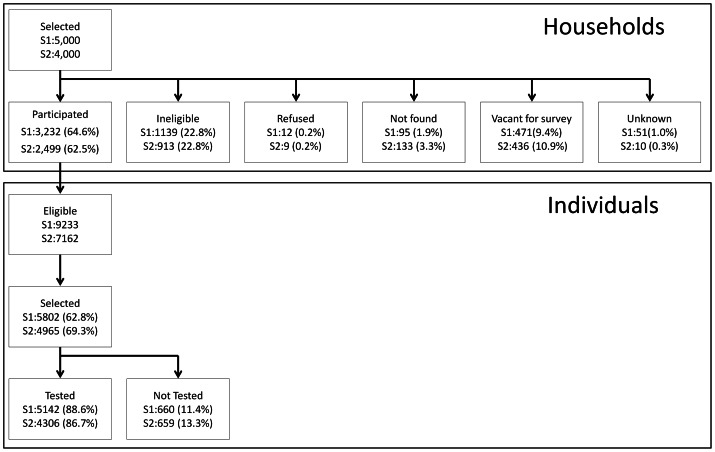
Study profile: Household and participant selection and participation in survey one (S1) and two (S2)